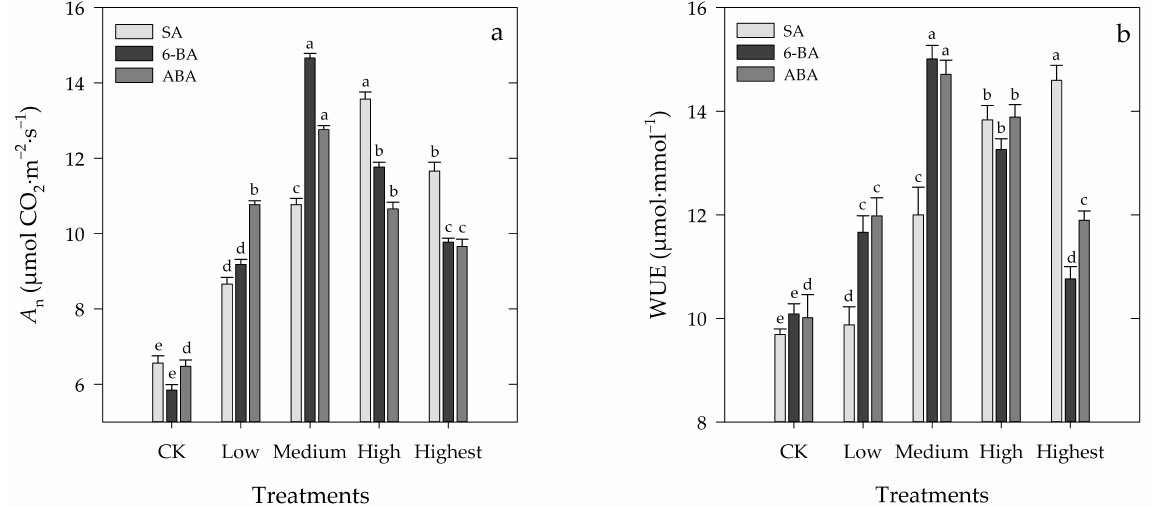
Figure 2. Effects of different concentrations of SA, 6-BA, or ABA on the net CO 2 assimilation rate net (A n , ( a )) and water use efficiency (WUE, ( b )) of Rosa hybrida ‘Carolla’. CK: distilled water.